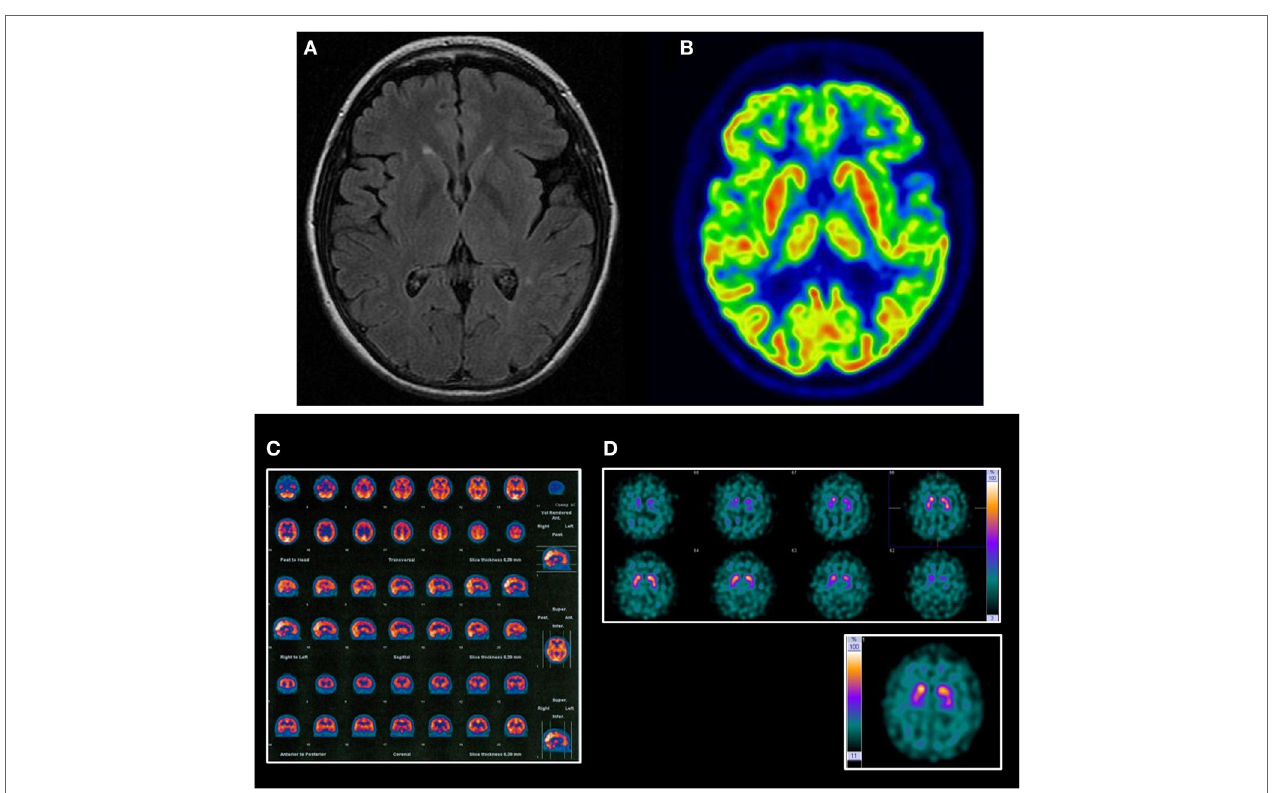
FigUre 1 | Neuroimaging findings in the reported case. (a) Follow-up MRI mild diffuse atrophy with more intense atrophy on the left frontal and temporal lobes and some small vessel lesions affecting periventricular and semioval white matter. (B) FDG-PET shows mild-to-severe hypometabolism on the left frontotemporal lobe junction and mild hypometabolism on the left fronto-basal, left anterior cingulum regions. (C) HMPAO SPECT shows bilateral but asymmetric hypoperfusion (more on the left side) on frontotemporal lobes. (d) Dopamine transporter-single, photon emission computed tomography was informed of the normal density ofpresynaptic dopaminergic uptakers. Some irregularities in the morphology of basal ganglia and increase of cortical uptake can be